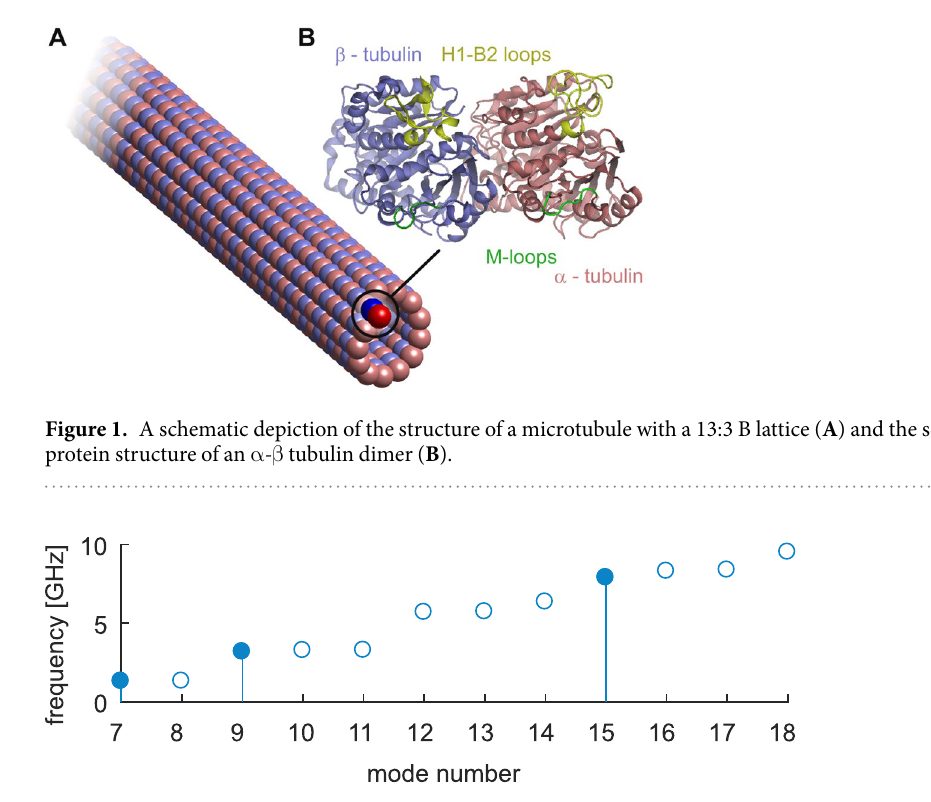
Figure 2. Frequencies of the first 12 nontrivial vibration modes of an approx. 320 nm long microtubule. The first nontrivial mode is mode number 7. The frequencies lie in a lower GHz range, which is in concordance with the predictions by other models. The three first modes of each type used in our analysis are depicted with line